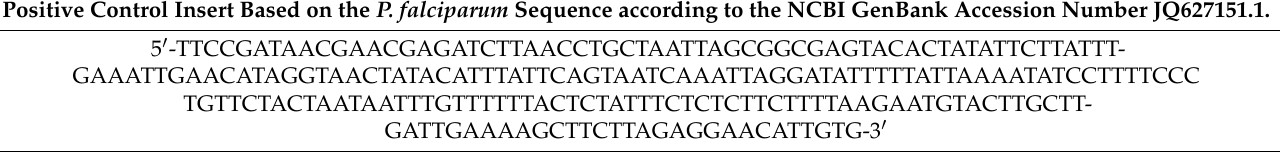
Table A1. Sequence inserts for the positive control plasmids of the SybrGreen-based malaria